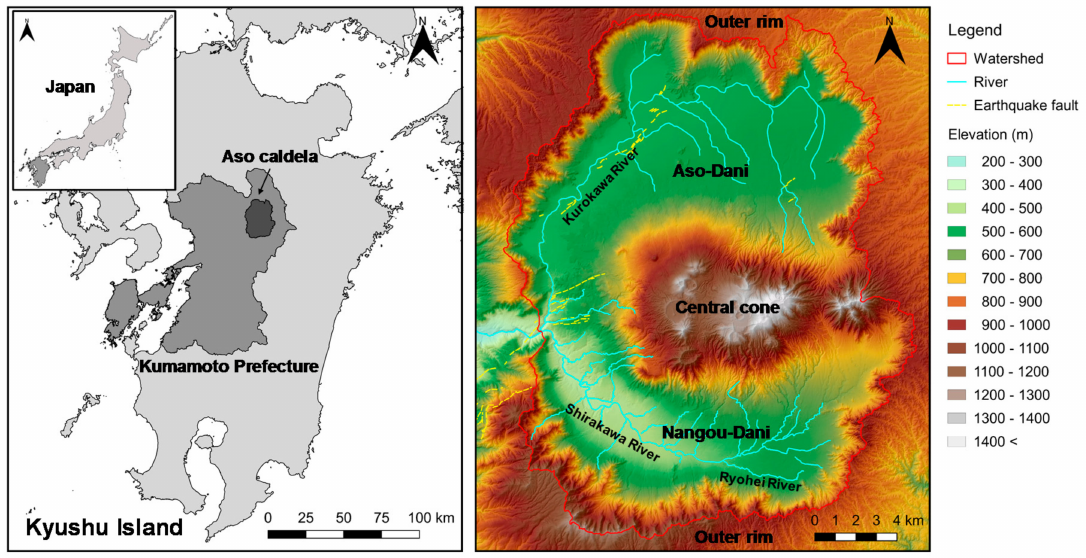
Figure 1. Location map of the study area, including Shirakawa and Kurokawa River